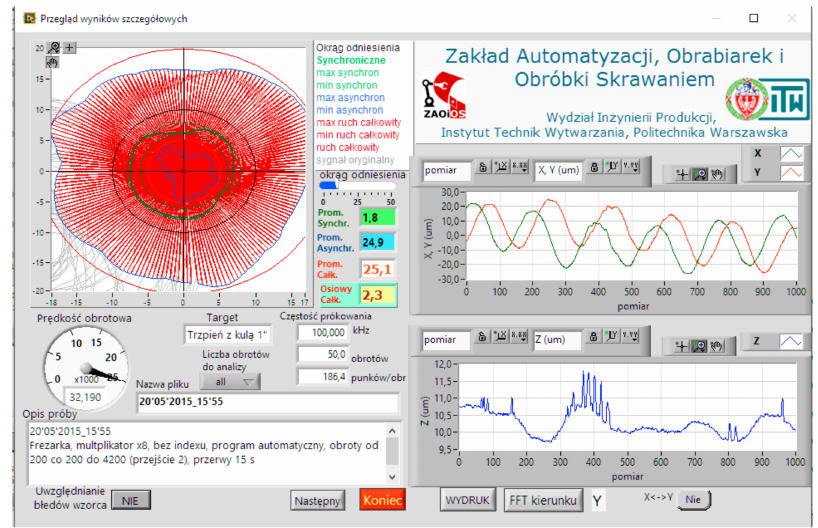
Figure 76. Screen with the results of detailed measurements of the multiplier—speed 32K min − 1